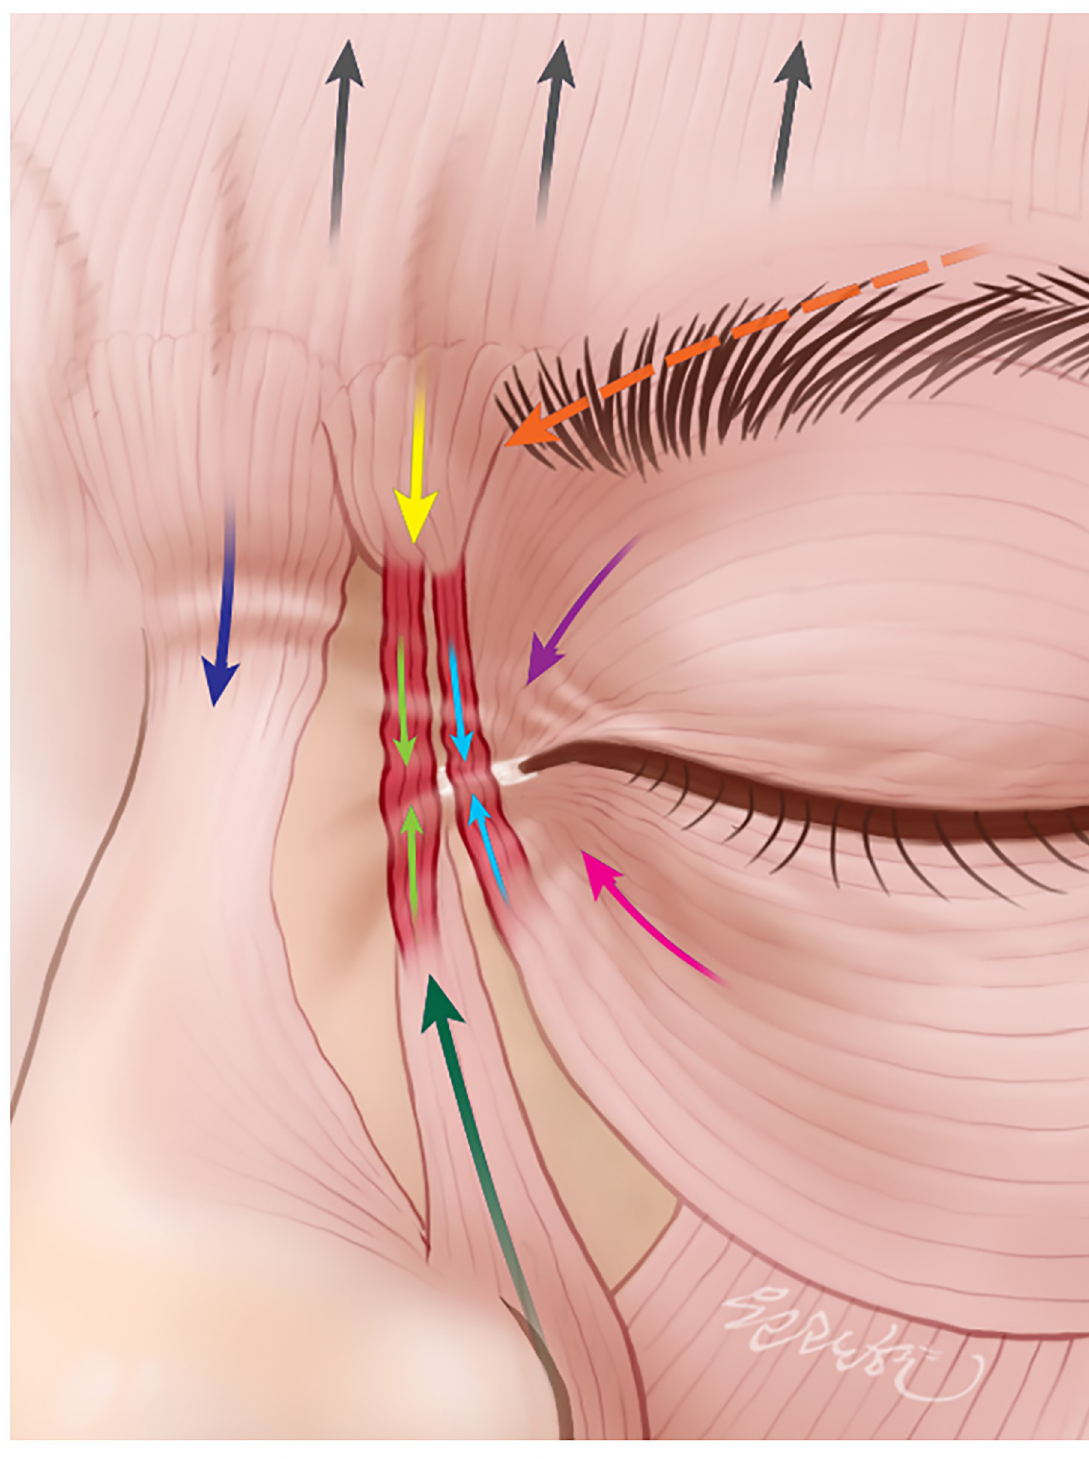
Fig 4. Contractions and vectors of the glabellar muscles and the fibers connecting the DS and the LLSAN and OOc INF while grimacing. Contracting the DS (yellow arrow) will pull the medial eyebrow down. Contracting the CS (orange arrow) pulls the eyebrow medially and down. Contracting the P (dark-blue arrow) depresses the medial eyebrow. Contracting the superior fibers of OOc (purple arrow) lowers and protrudes the eyebrow inferomedially. Contracting the OOc INF (pink arrow) elevates the cheek superomedially. Contracting the frontalis (black arrows) elevates the eyebrow. Contracting the LLSAN (green arrow) elevates the nasal ala and upper